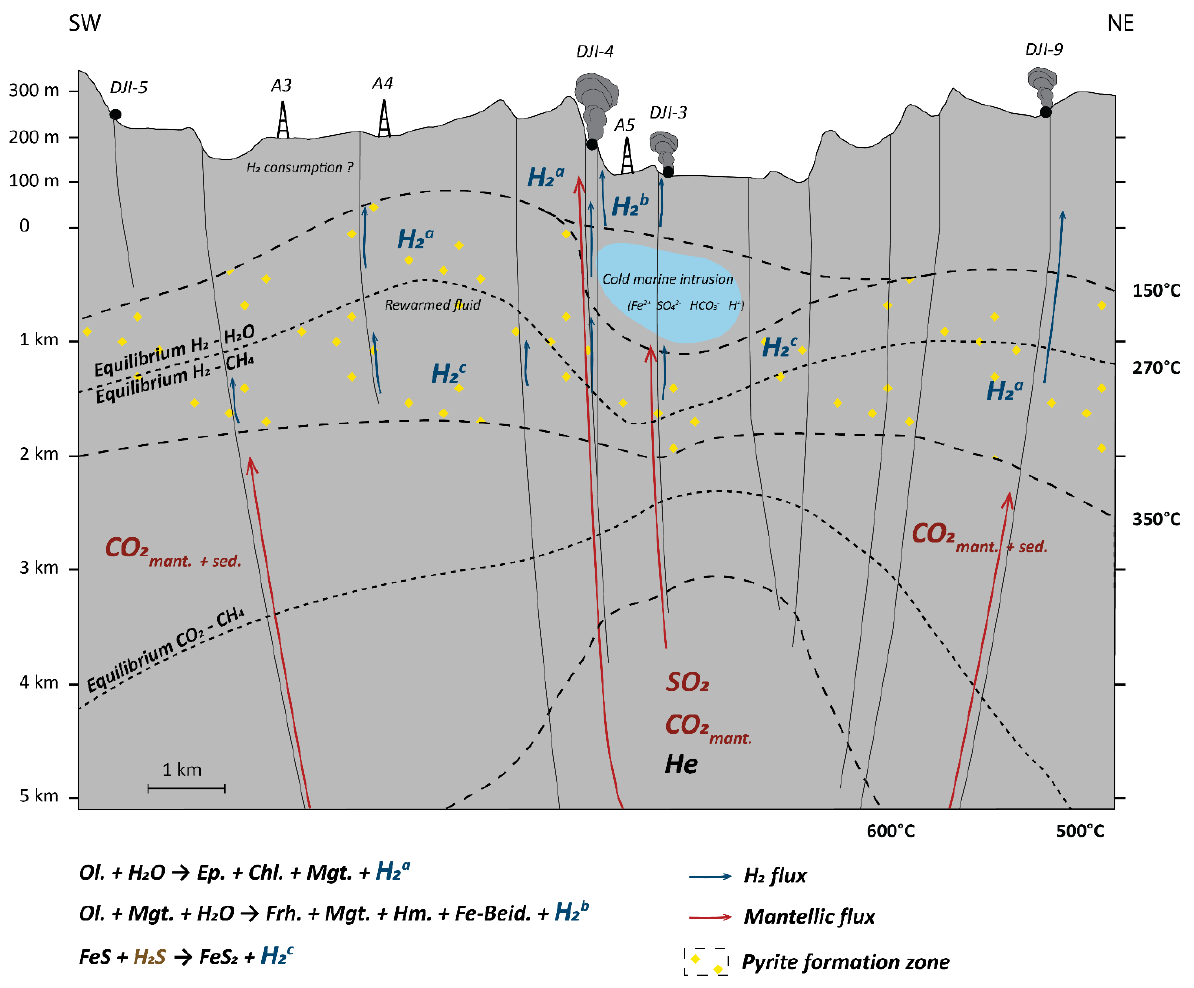
Figure 17. Schematic model of the Asal Rift highlighting gas flows and possible origins of hydrogen measured at the surface in fumaroles. Beid.: beidellite; Chl.: chlorite; Ep.: epidote; Frh.: ferrihydrite; Hm.: hematite; Mgt.: magnetite; Ol.: olivine.